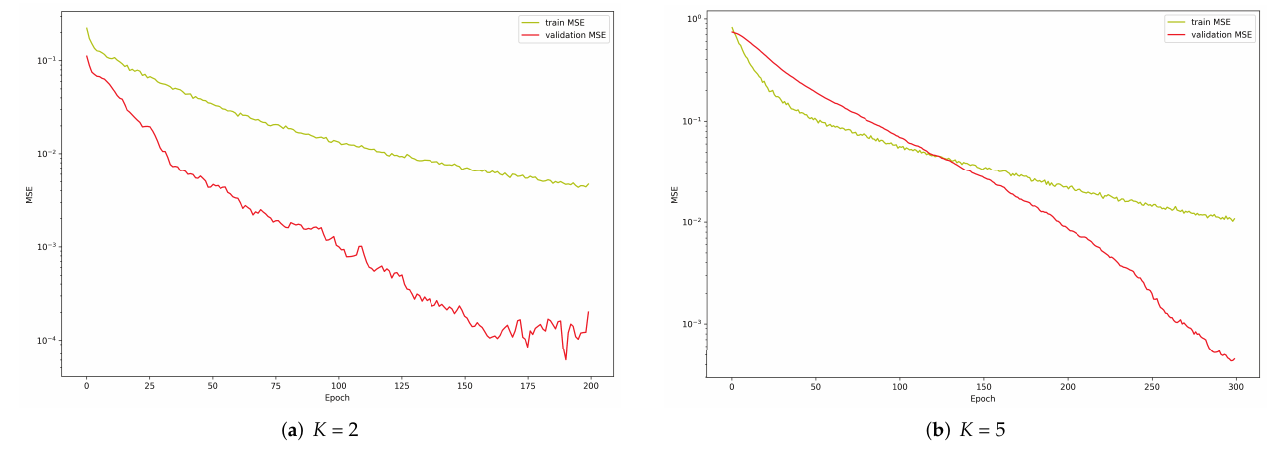
Figure 7. Learning curve of the proposed scheme for the uplink with v = 160 km/h.